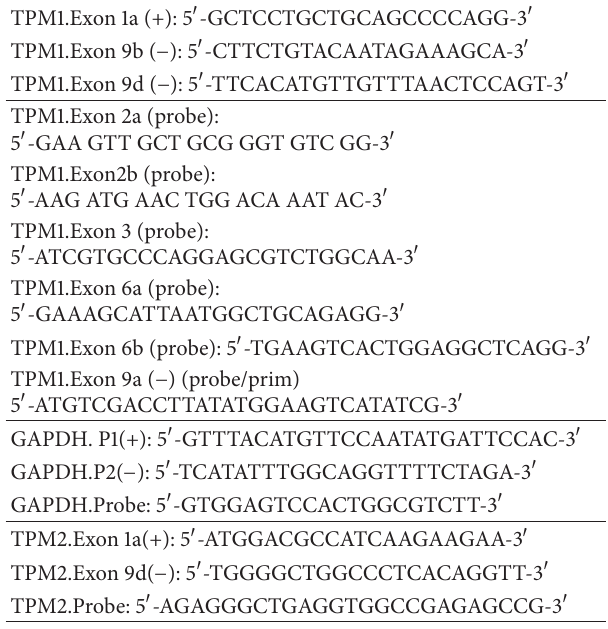
Table 1: Nucleotide sequences of the primer pairs and probes used to amplify and detect TPM2